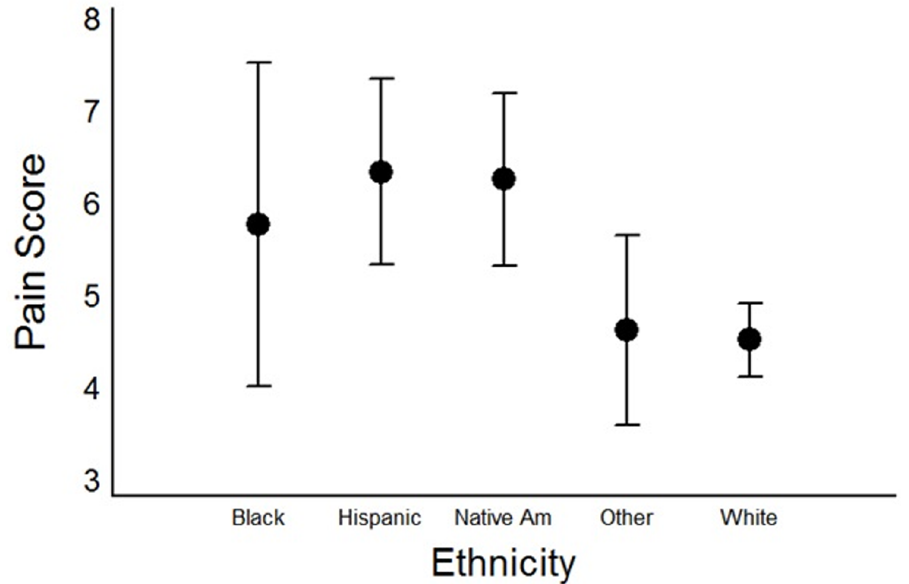
Fig 1. Ethnicity and pain scores. Mean knee-pain scores in 355 patients with knee osteoarthritis, according to patients’ ethnic or racial group. The error bars represent 95% confidence intervals adjusted by using the Tukey procedure for multiple comparisons. The difference between Hispanic and white patients and between Native American and white patients was significant (p < 0.001 for both comparisons).